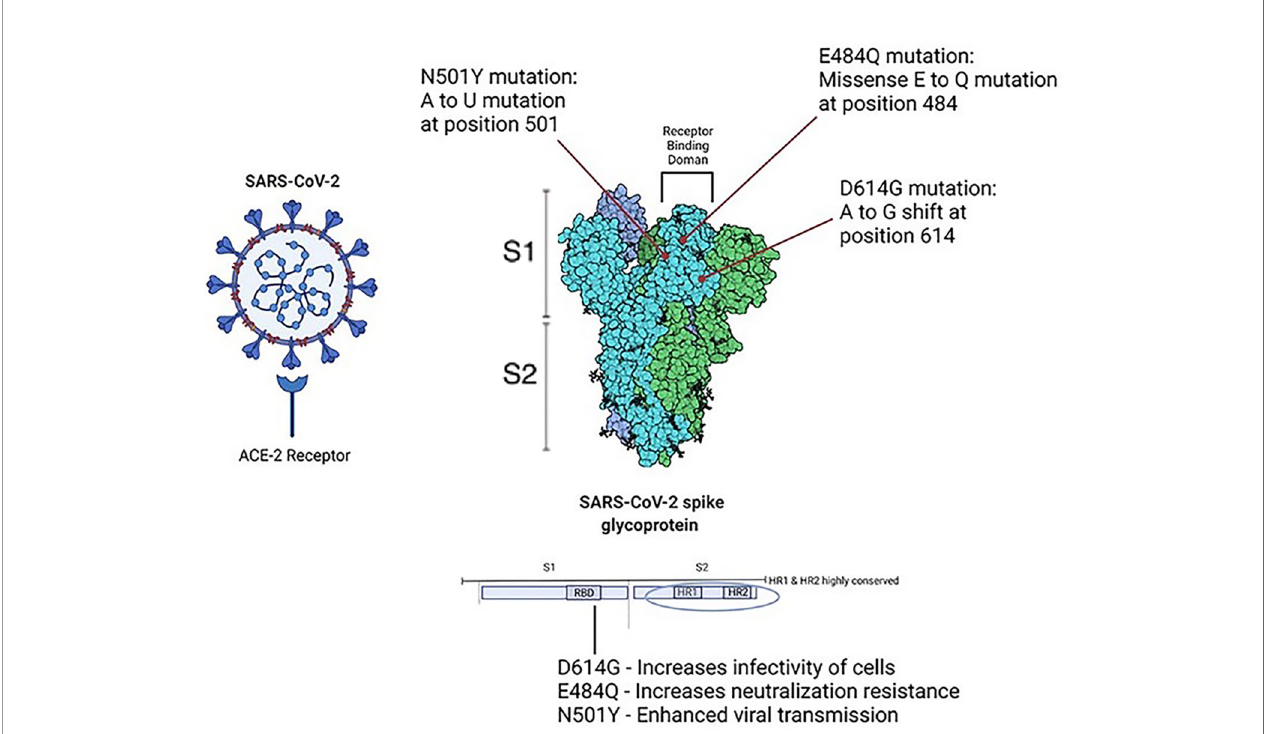
FIGURE 2 | The structural and functional aspects of SARS-CoV-2. Point mutations in Spike protein have been shown to increase survival of SARS-CoV-2 virion from host immune response. D614G is related to increased infectivity of cells, E484Q has been shown to increase neutralization resistance, and N501 Y has been shown to cause enhanced viral